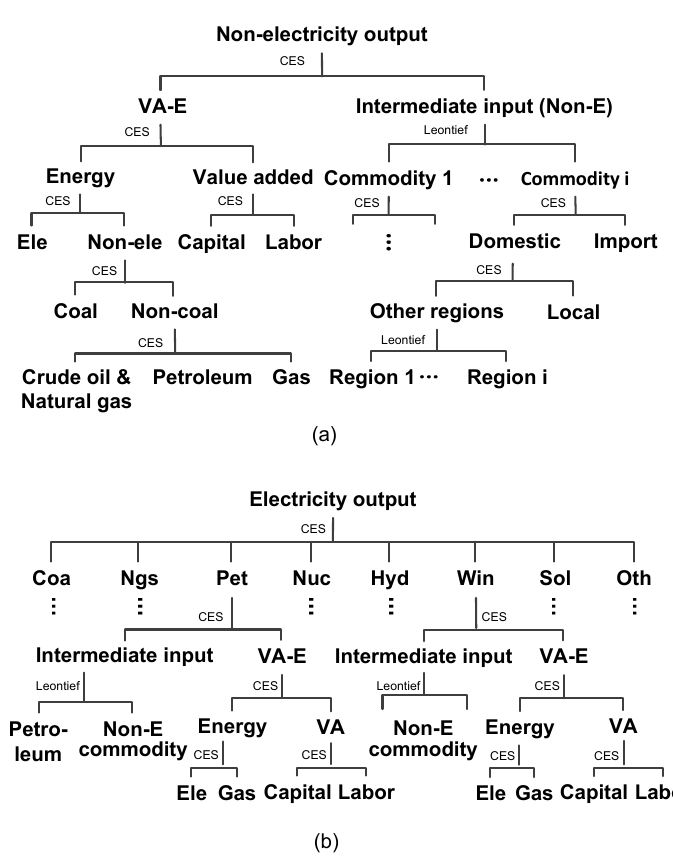
Figure 1. Structure of production for non-electricity and electricity sectors: ( a ) non-electricity sectors; ( b ) electricity sector.